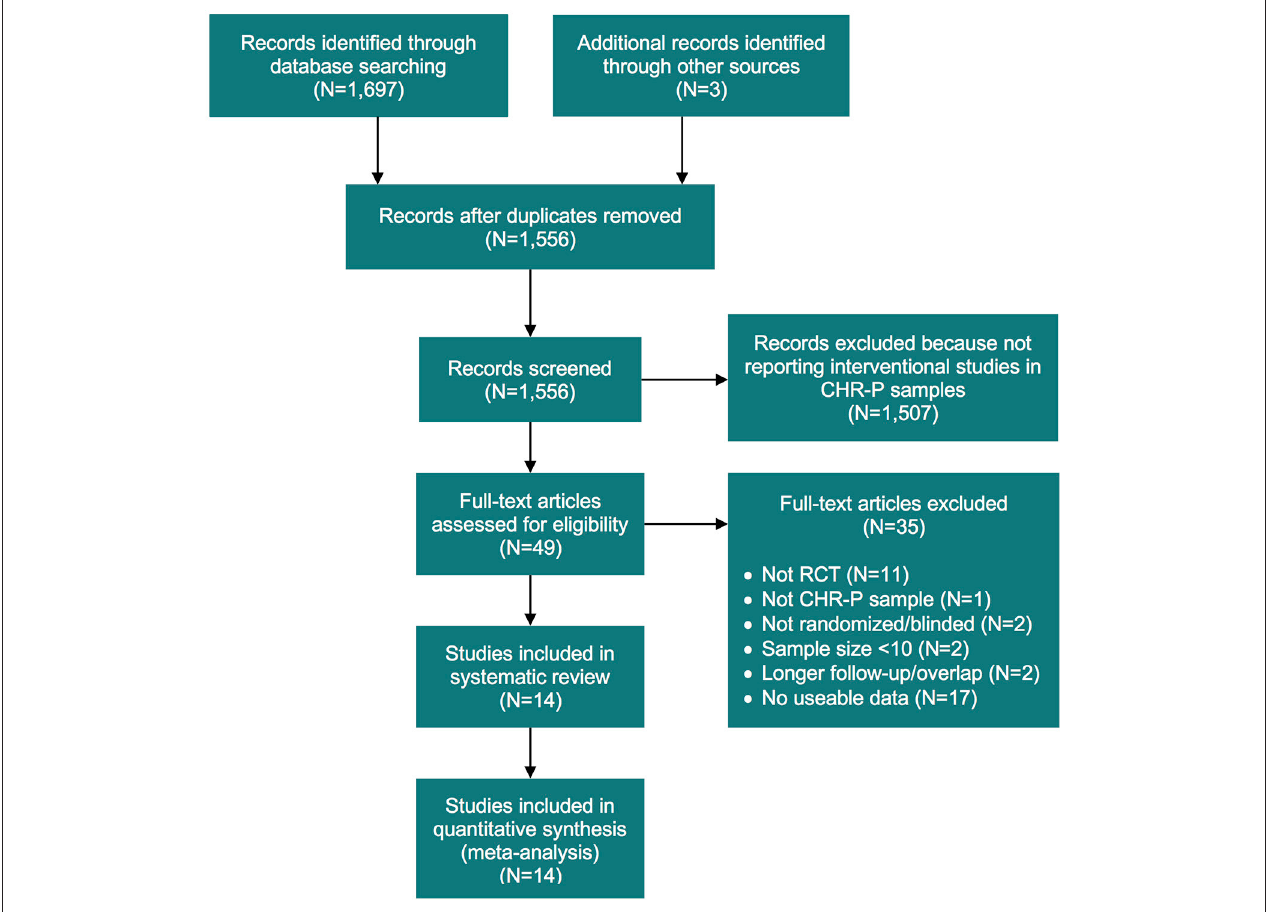
FIGURE 1 | PRISMA flow chart of the study selection process. CHR-P, clinical high risk for psychosis; RCT, randomized controlled trial.